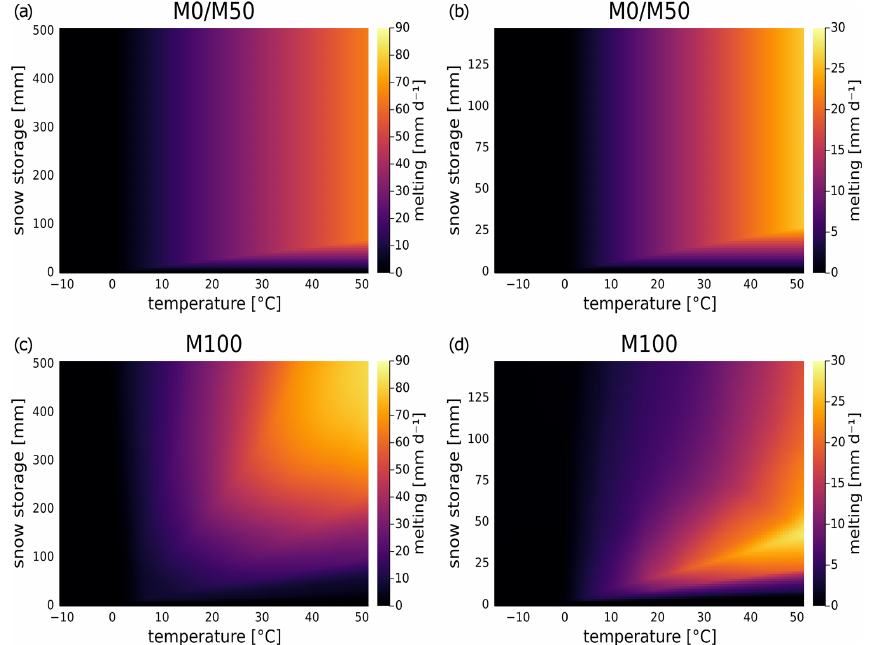
Figure 7. Dependence of melting rate on temperature and snow storage for neural ODE models M0/M50 and M100 in basin 1013500 (left; a and c , respectively) and in basin 6431500 (right; b and d , respectively). For NN 100 , the additional neural network inputs were fixed at basin averages of water storage and precipitation (3mmd − 1 for basin 1013500 and 1.9mmd − 1 for basin 6431500) over the training